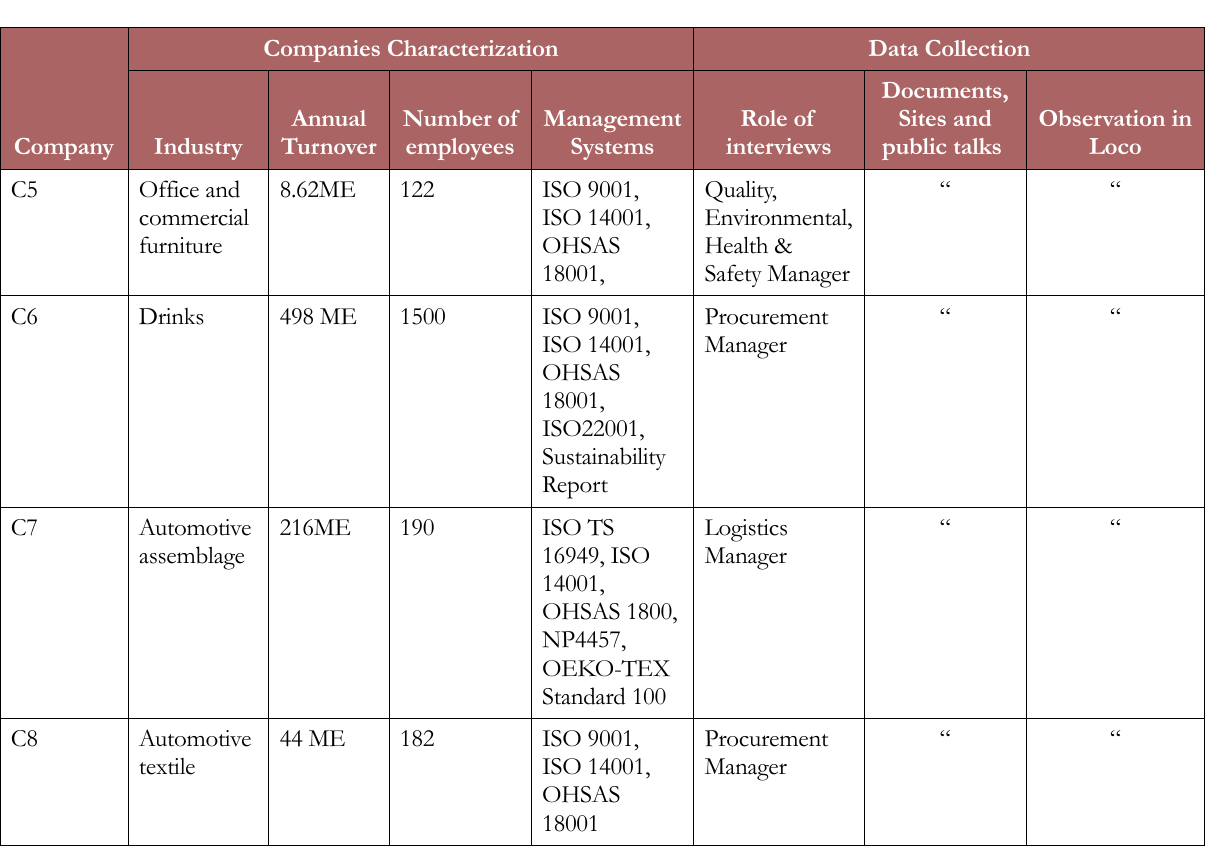
Table 2. Characteristics of the